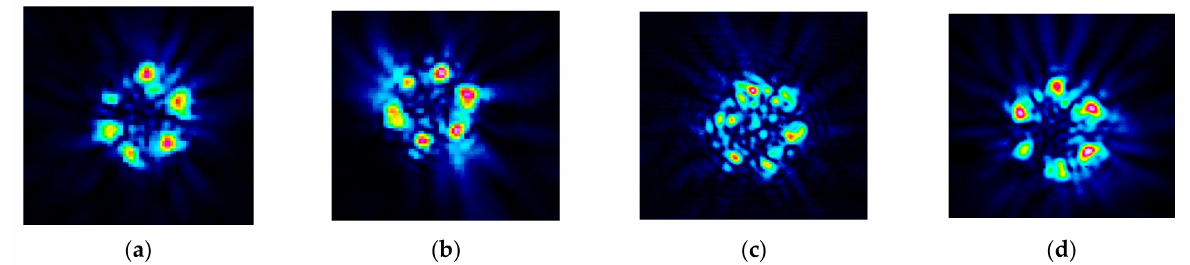
Figure 18. Far-field laser beam profiles, measured at the receiving end after propagation over 5 m long twisted six-core-MOF, connected to SL ( λ = 980 nm) via special SMF with air gap 150 . . . 200 µ m to provide OFL conditions: ( a ) 50 rpm twisted graded-index six-core-MOF; ( b ) 100 rpm twisted graded-index six-core-MOF; ( c ) 50 rpm twisted step-index six-core-MOF; ( d ) 100 rpm twisted step-index